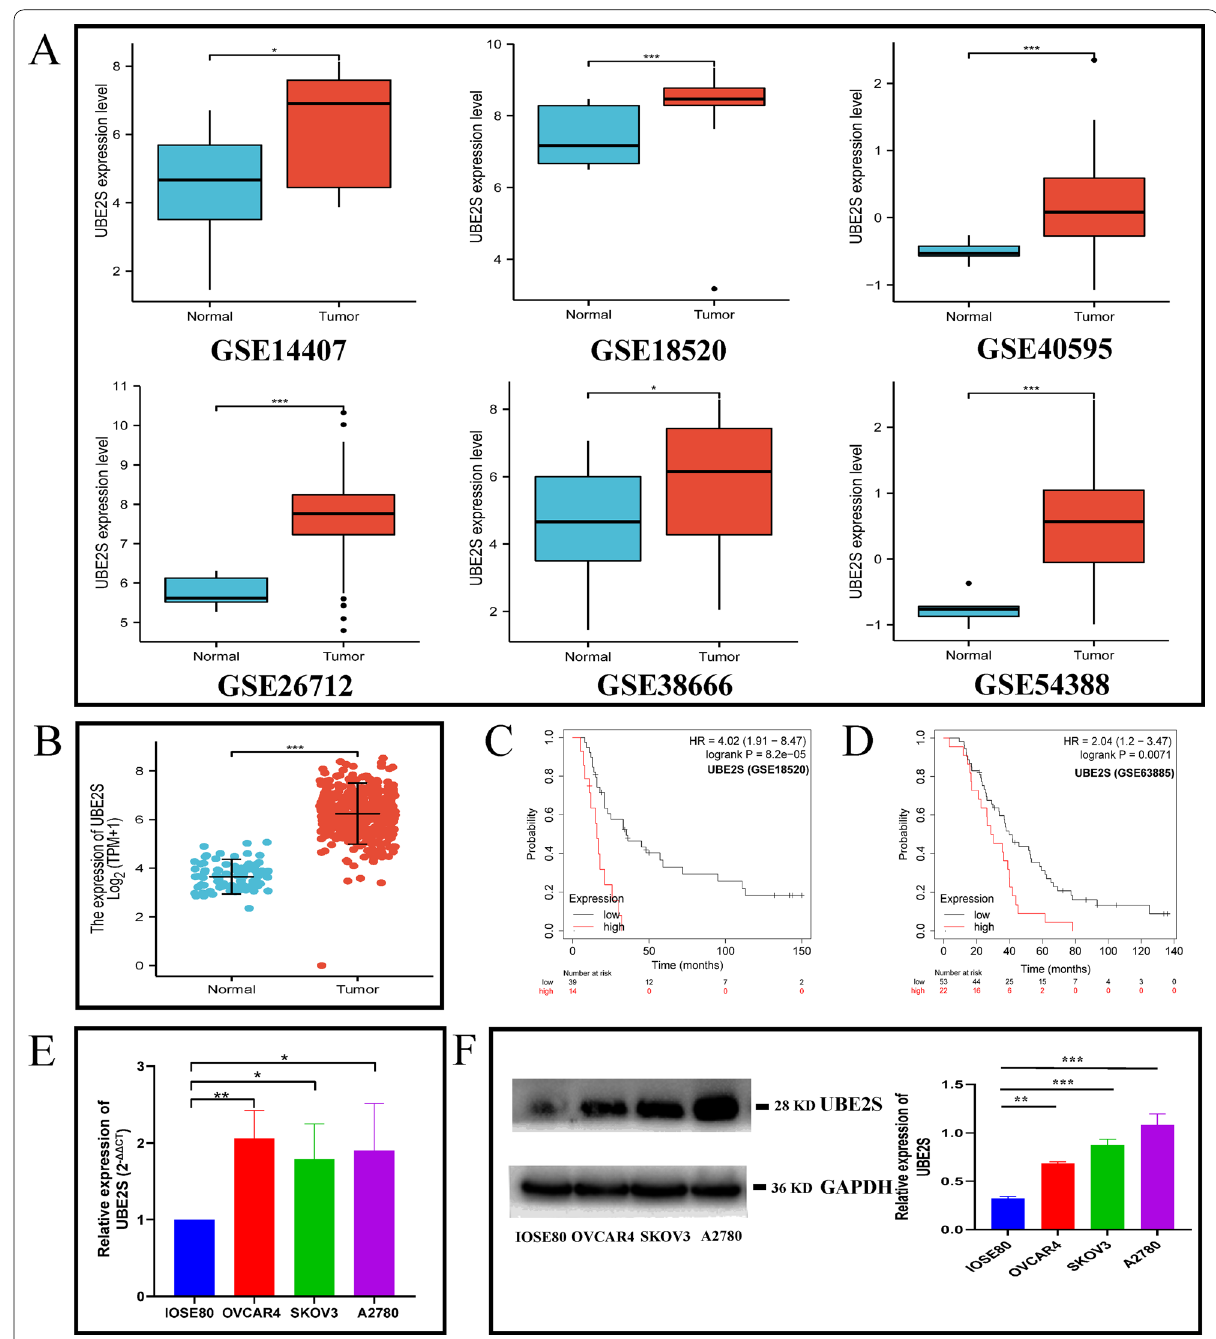
Fig. 3 The expression of UBE2S in OV according to high-throughput database and low-throughput in vitro experiments. A The mRNA expression level of UBE2S in ovarian cancer tissues and corresponding control tissues based on six GEO database (GSE14407, GSE18520, GSE40595, GSE26712, GSE38666 and GSE54388). B Scatter plot of UBE2S expression levels in ovarian cancer tissues and corresponding control according to TCGA data (tumor 427, normal 88). C Survival curve of UBE2S high/low expression group in ovarian cancer GEO dataset GSE18520 (HR 4.02, P = D Survival curve of UBE2S high/low expression group in ovarian cancer GEO dataset GSE63885 (HR 2.04, P of UBE2S in OV cell lines (SKOV3, A2780, OVCAR4) and normal cell lines (IOSE80) based on RT-qPCR. F The protein expression levels of UBE2S in ovarian cancer cell lines (A2780, SKOV3, OVCAR4) and a normal ovarian cell line (IOSE80) based on western blotting in this